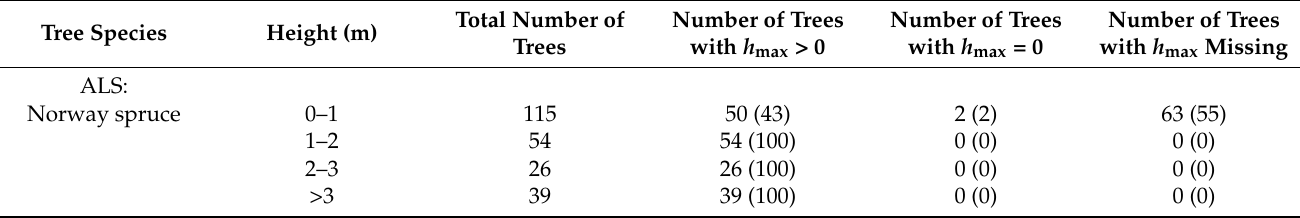
Total Number of Number of Trees Number of Trees Number of Trees Trees with h max > 0 with h max = 0 with h max Missing